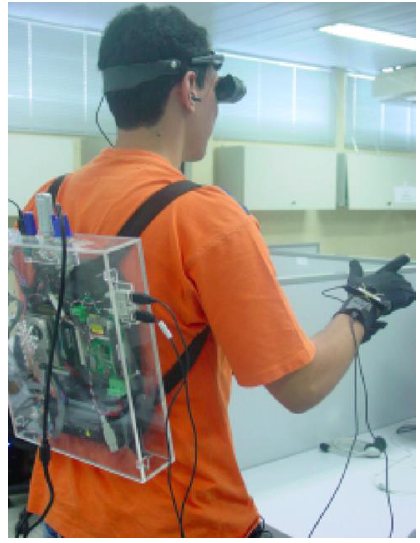
Figure 2. Wearable computer interface – the miva being used